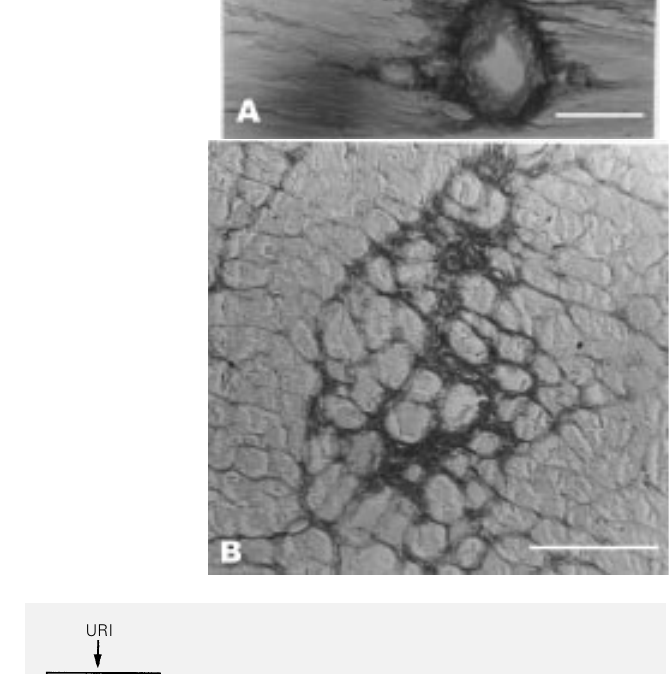
Figure 3 - Photomicrographs of rat myocardium after 8 weeks of renovascular hypertension. Panels A and B illustrate in- creased perivascular and peri- cellular fibrosis, and scarring (dark-stained collagen). Magnifi- cation bar: 500 µm; Sirius Red F3BA staining.